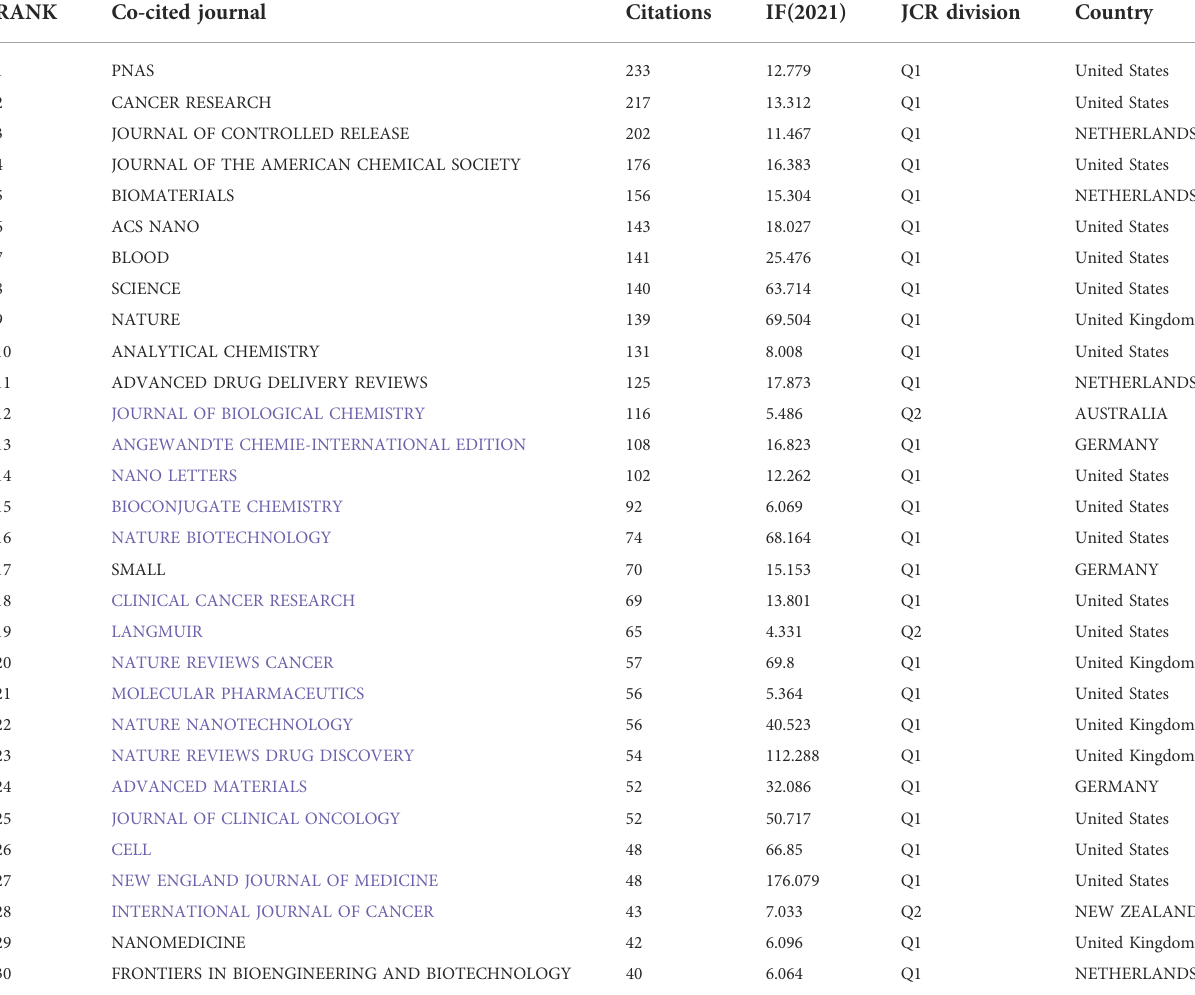
TABLE 8 The top co-cited 20 journals of top100 cited articles